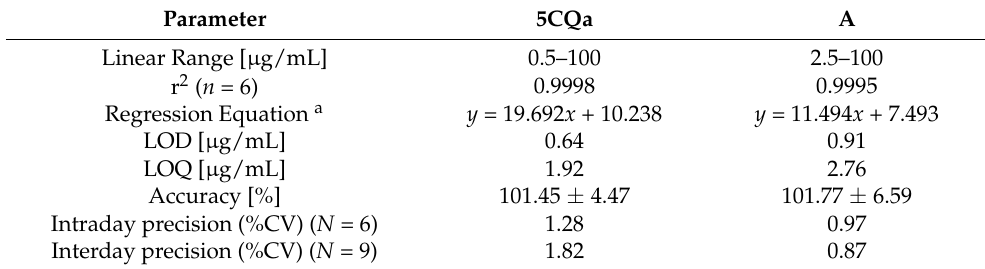
Table 5. Validation parameters for CQAs and A derivatives analysis by